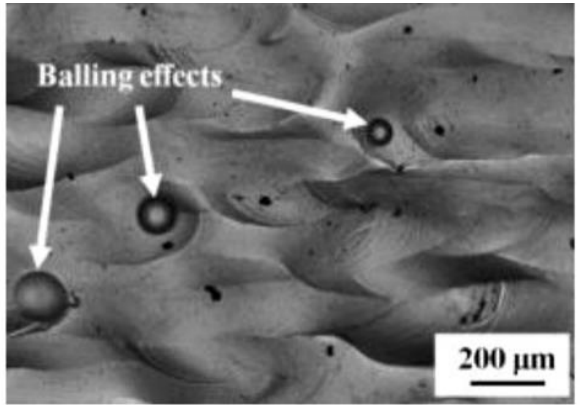
Figure 13. Surface topography of a specimen manufactured by selective laser melting (SLM). Reproduced from [137] (Open access, no copyright).